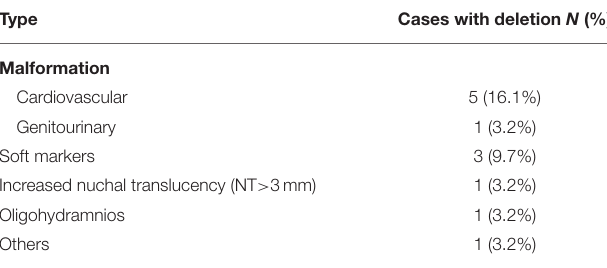
TABLE 2 | Different types of abnormal ultrasound were detected in 15q11.2 microdeletion